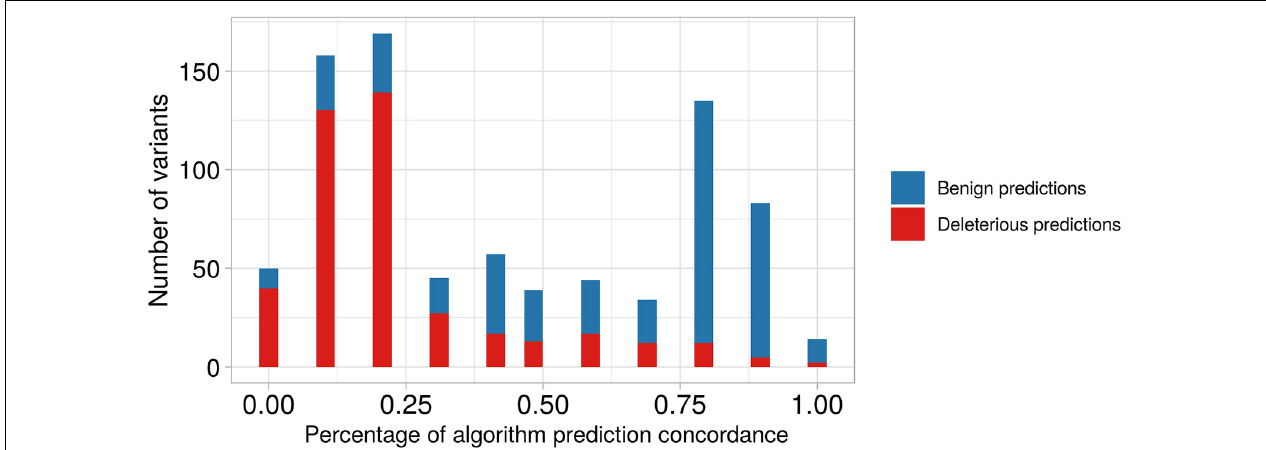
FIGURE 3 | Barplot of predictive algorithm concordance between benign versus deleterious variant predictions. On the x -axis, we show the percentage of concordance among the different algorithms. On the y -axis, we show the number of predicted variants. For example, the second bar represents the number of variants predicted with low concordance among different algorithms ( ∼ 12.5%), and we observe that the number predicted to be deleterious is higher than that predicted to be benign. In contrast, the tenth bar shows predictions with high concordance among algorithms ( ∼ 87.5%), and we observe that the number of predicted benign variants is higher than predicted deleterious